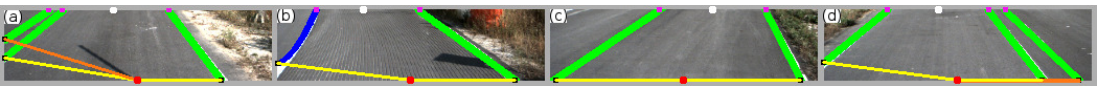
Figure 6. Centroid and lane marking ending points extraction. ( a – d ) show the result of the point extraction for a set of frames. Points in white show the centroid of the lane region. Points in magenta and black show the top and bottom pixel position, respectively, for each detected line/curve. Points in red show the center at the bottommost part of the image used to estimate the shortest distance. Lines in yellow show the nearest distance to the left and right side. Lines in orange show the largest distance to the left and right